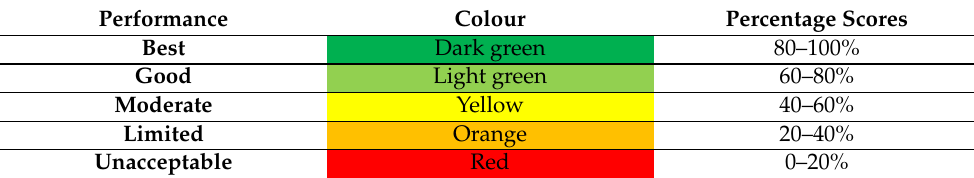
Table 3. Categories of performance associated with colours and percentage scores. Source informa- tion: SAFA